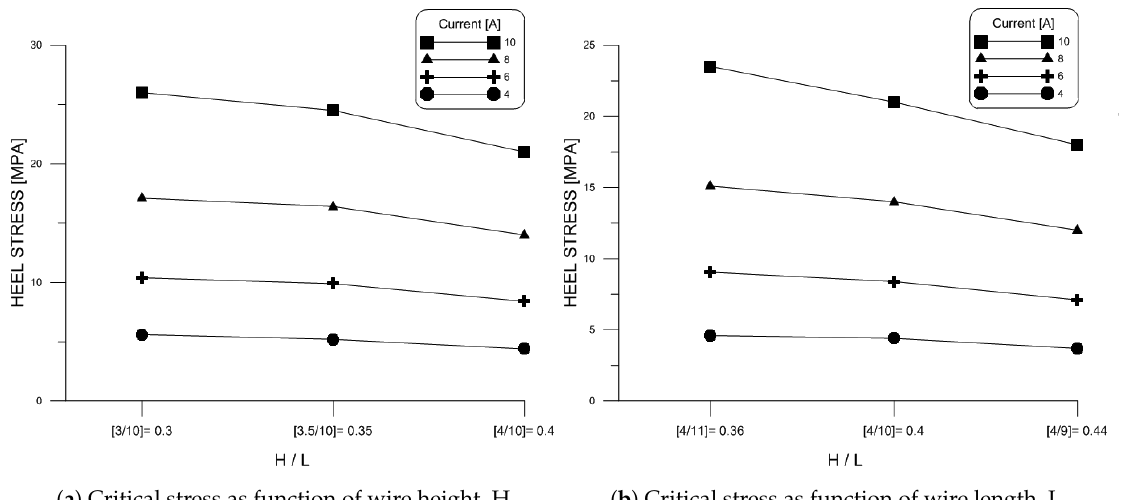
Figure 9. Impact of aspect ratio on the critical stress in Al wire under dc